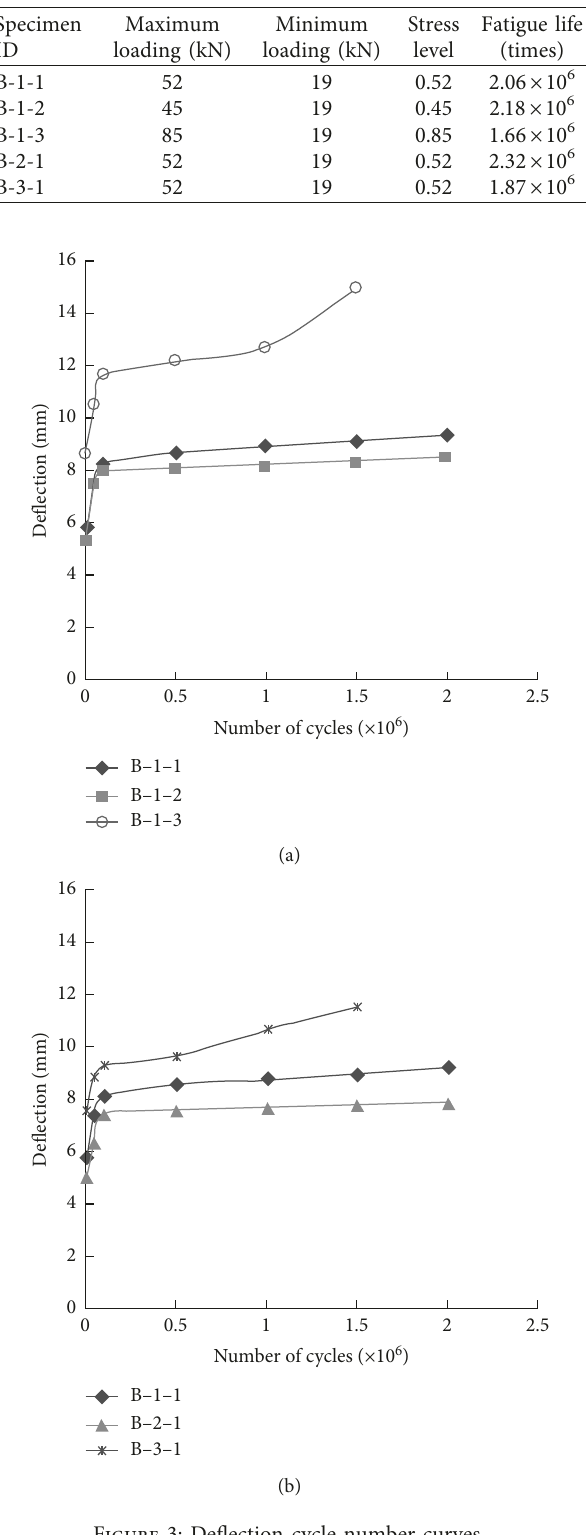
Table 3: Imposed conditions and the corresponding fatigue life.